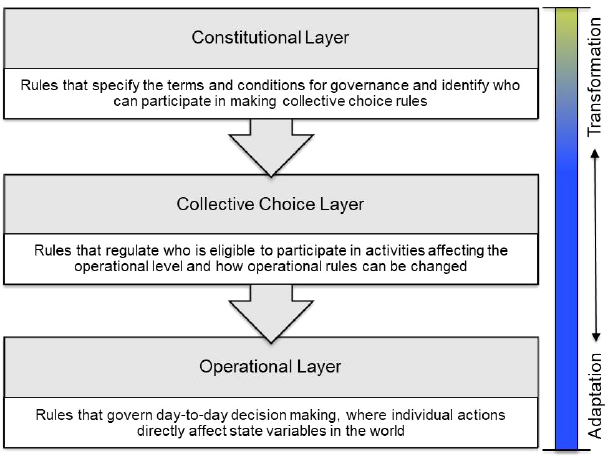
Fig. 1. A theoretical organizing framework that links processes of change in social–ecological systems to Kiser and Ostrom’s (1982) multilayered action situation of the IAD framework, which conceptualizes decision making with rules of different types that fall within a